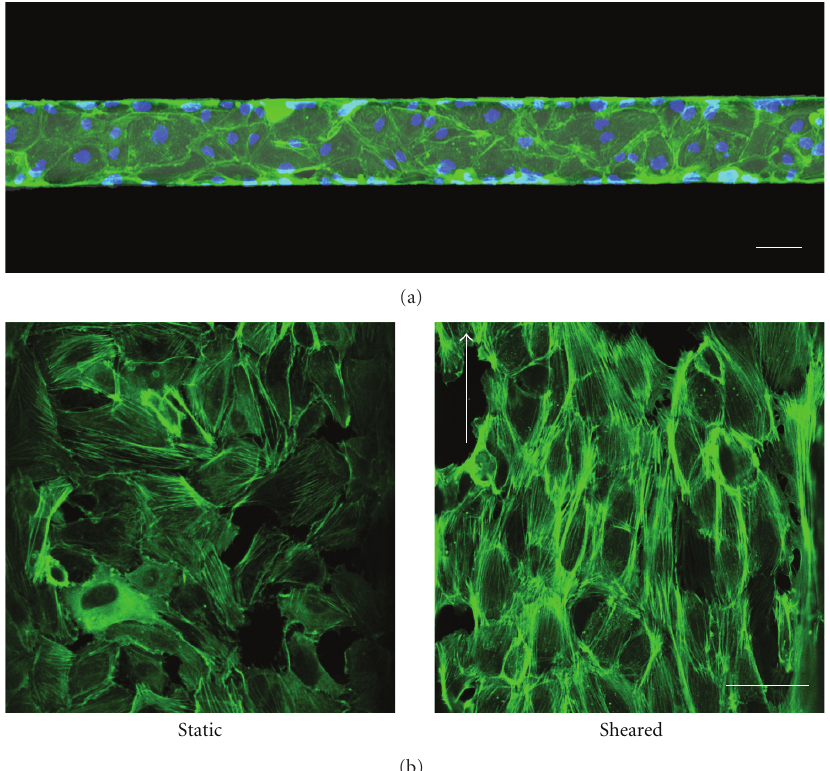
Figure 4: Endothelial cells in a microfluidic channel. (a) Human umbilical vein endothelial cells were cultured in a microfluidic channel. When reaching confluence, the cells were fixated with paraformaldehyde and stained for actin filaments (green) and nuclei (blue). Scale bar is 50 μ m. (b) Endothelial cells that are subjected to physiological levels of shear stress inside microfluidic channels reorient their actin cytoskeleton to align with the direction of fluid flow (right). Scale bars are 50 μ